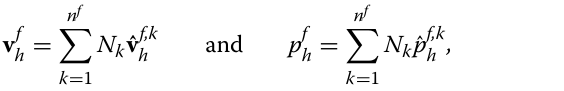
andpointouthowtheywereovercomewithinthepresentwork.Afterwards,thenumerical treatment of the coupling terms will be presented in more